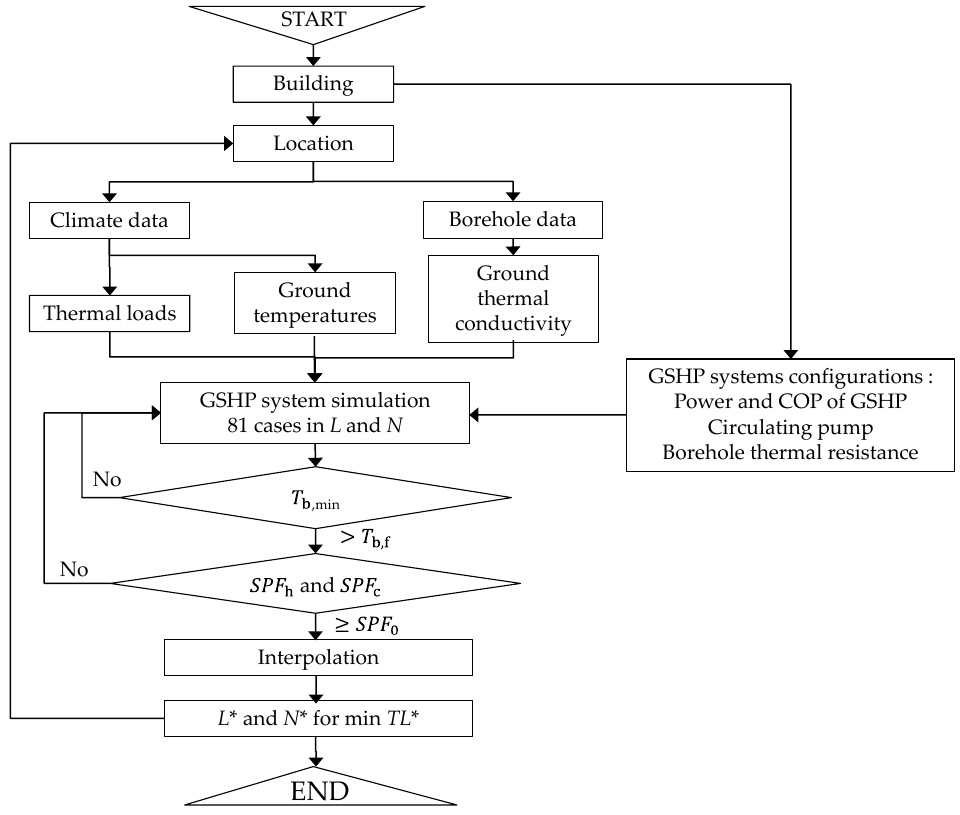
Figure 1. Schematic flow of determination of required total lengths of multiple borehole heat exchangers (BHEs) in this study.